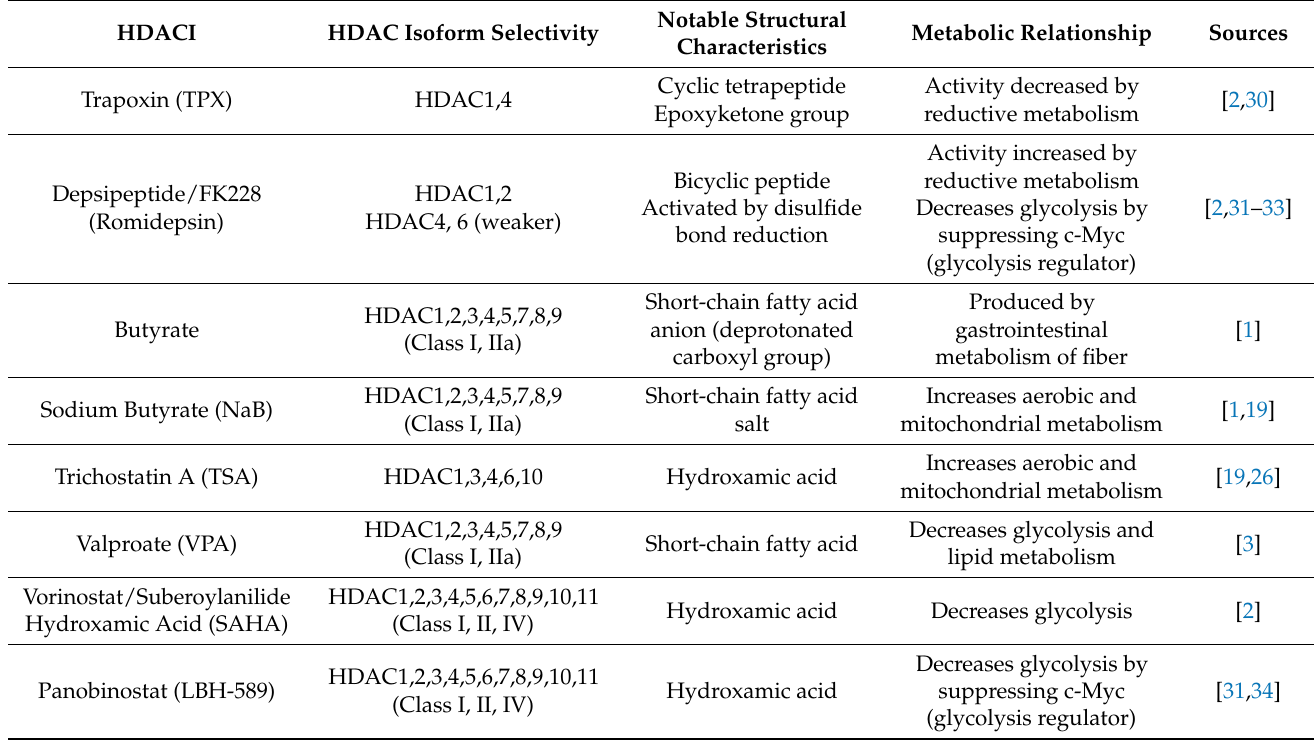
Table 1. Table summary of common HDACIs’ isoform selectivity, structure, and connection to metabolism. HDACI